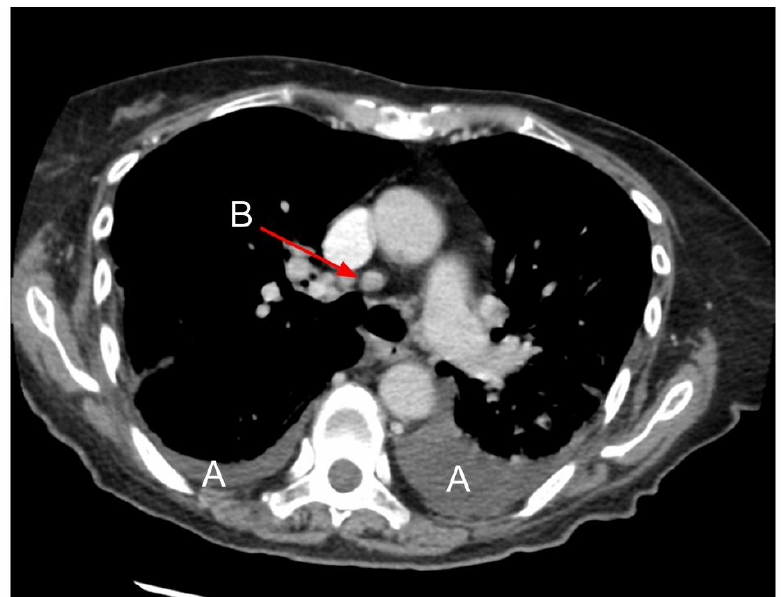
Figure 12. Mediastinal lymphadenopathy in CT. A: Bilateral pleural effusion; B: Lymphadenopathy of pretracheal lymph nodes (4R). Figure obtained with permission from the 2nd Department of Radiology, Medical University of Warsaw.